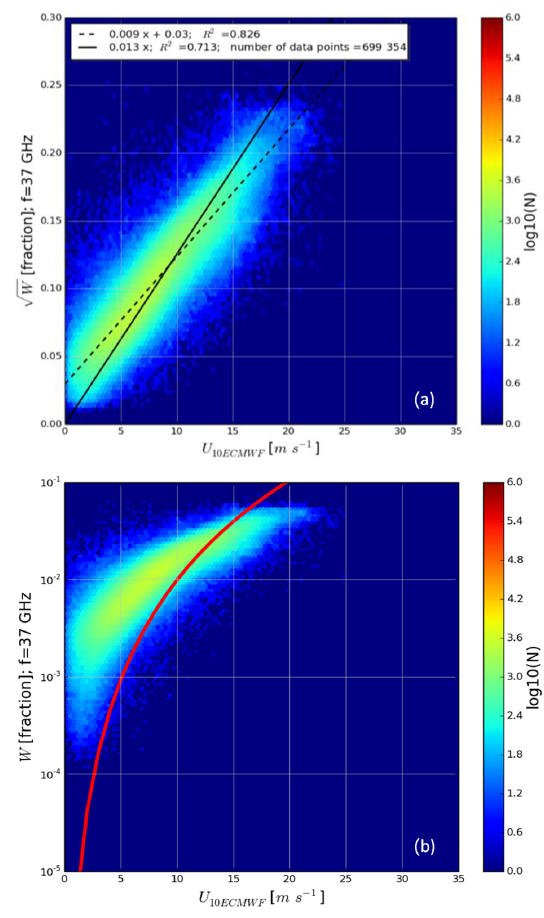
Figure 7. Scatter plots of W data for 37GHz vs. U 10ECMWF for March 2006: (a) W 1 / 2 ; (b) W obtained with Eq. (12). The black lines in panel (a) are linear fits: the dashed line represents unre- stricted fit and the solid line is a fit forced through zero. The lin- ear fits and respective R 2 are listed. The red line in (b) indicates the Monahan and O’Muircheartaigh (1980, MOM80) relationship (Eq. 3). The colors indicate the amount of data points per